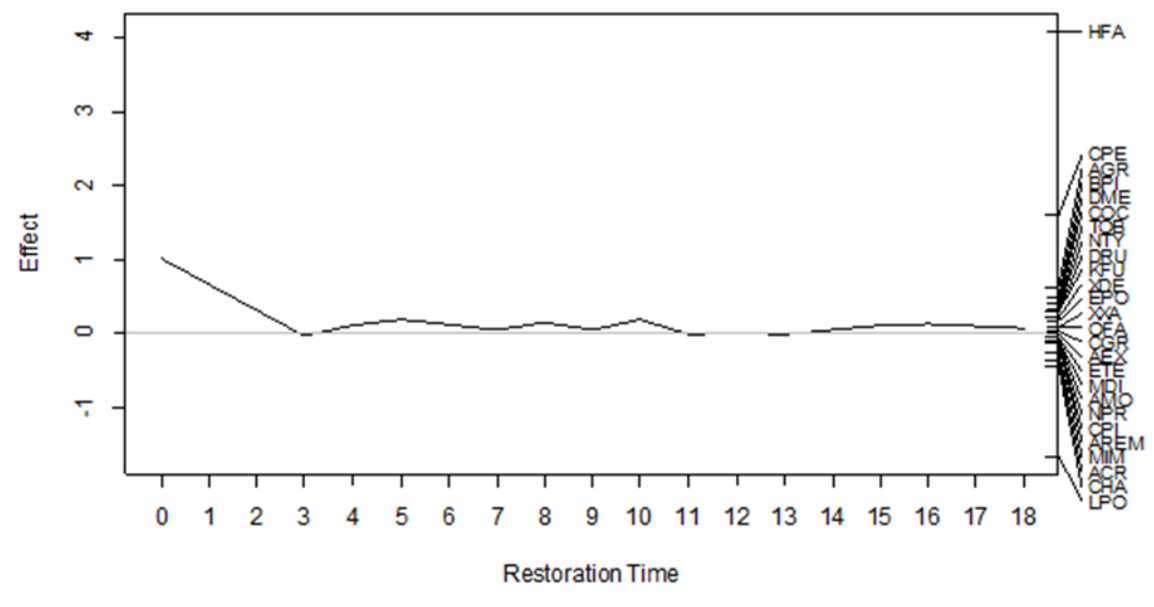
Figure 1. Principal Response Curve (PRC) for the restoration trajectory of moth assemblages. The Y axis represents the PRC scores at each restoration age class; the X axis represents the time (in years) since restoration began. Open blanket bog (baseline) is the grey line; restoration is the solid black line (hidden behind bog baseline when values overlap); forestry (unfelled conifer plantations) is the first point of restoration (t = 0). With bog as the baseline, species above 0.5 on the Y axis display strong affinity with restoration treatments, whereas species below 0.5 display strong affinity with bog treatments. Only best fitting species are shown (species weight > 0.5). Species names are provided in Table